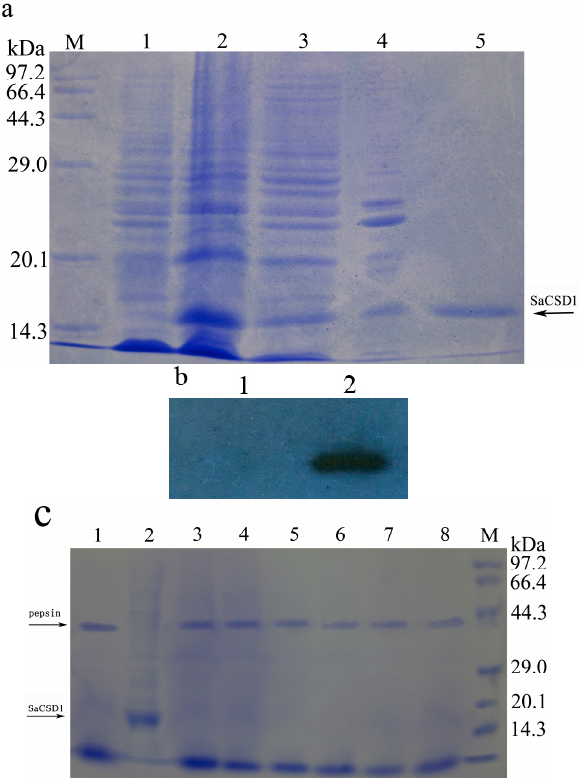
Figure 2. Expression, purification, Western Blot and pepsin digestion analysis of recombinant SaCSD1 protein. ( a ) Electrophoretogram of SaCSD1 protein. Lane M, protein marker; lane 1, uninduced E. coli